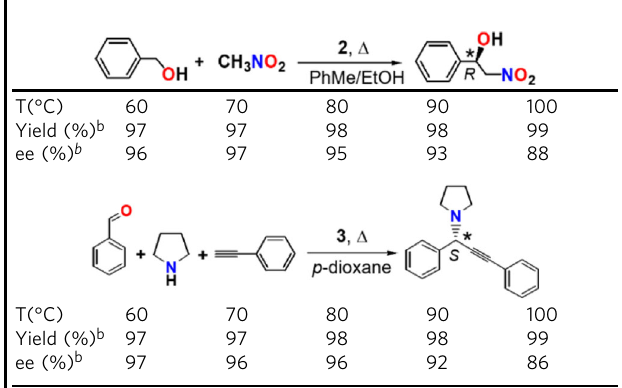
Table 5 2- and 3-catalyzed asymmetric reactions at different temperatures a